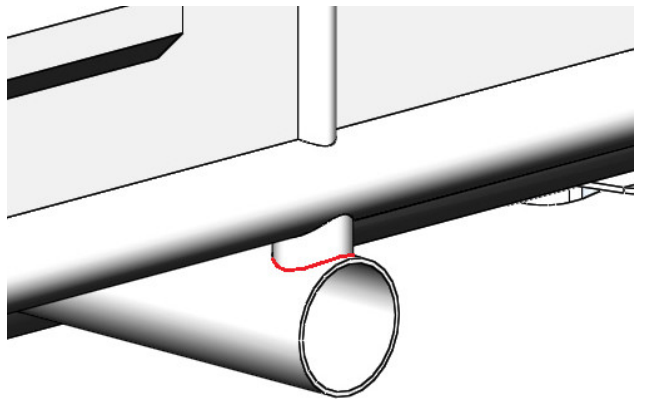
Figure 5. Contact assembly between the intermediate vertical post and the cross bearer of an open wagon frame.